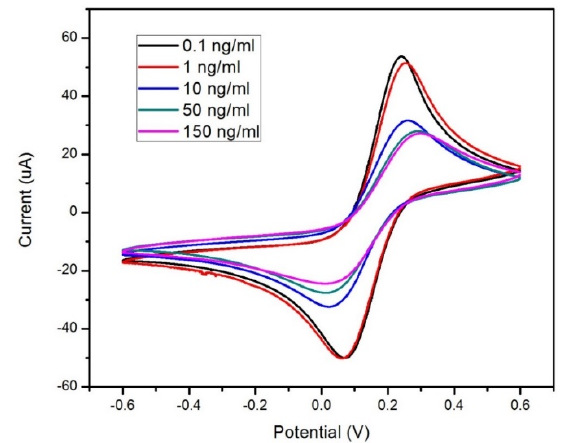
Figure 7. Electrochemical current responses via cyclic voltammetry testing on the biosensor based on cortisol concentrations between 0.1–150 ng/mL. A potential range of ±0.6 V was used with K 4 FeCN 6 in PBS as the redox moiety at a scan rate of 50 mV/s.